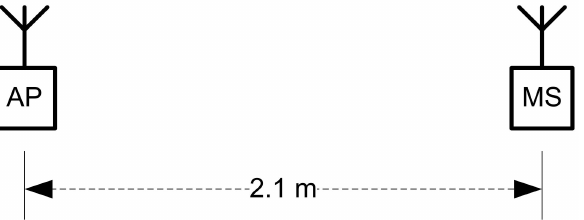
Figure 11. Test bed setup for signal strength variation